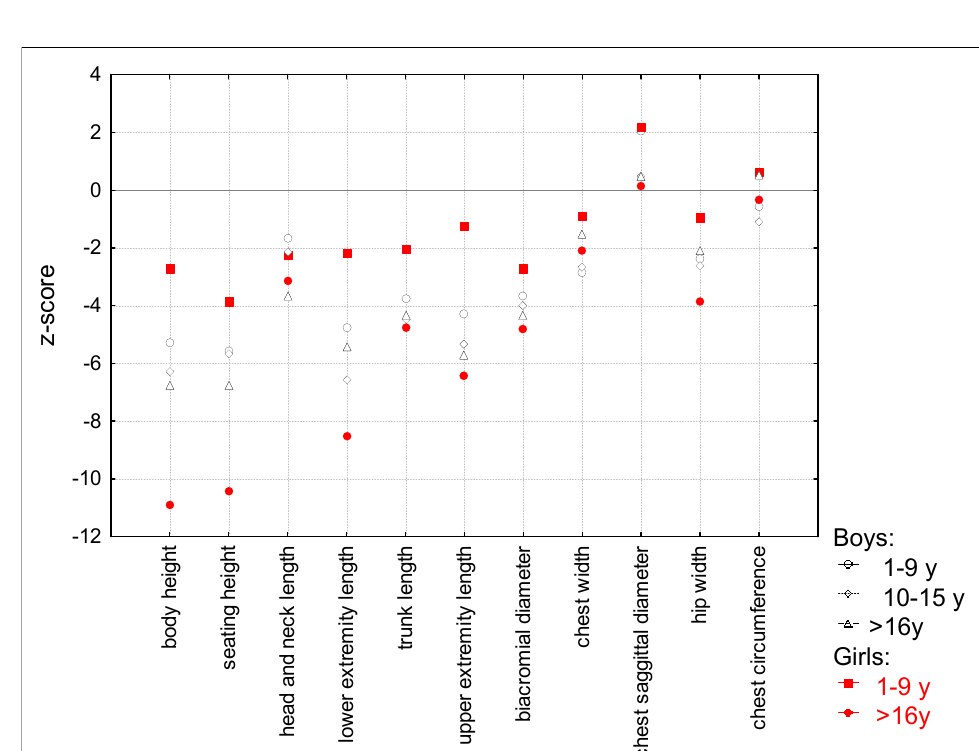
Figure 3. Somatometric pattern profile in three age groups.